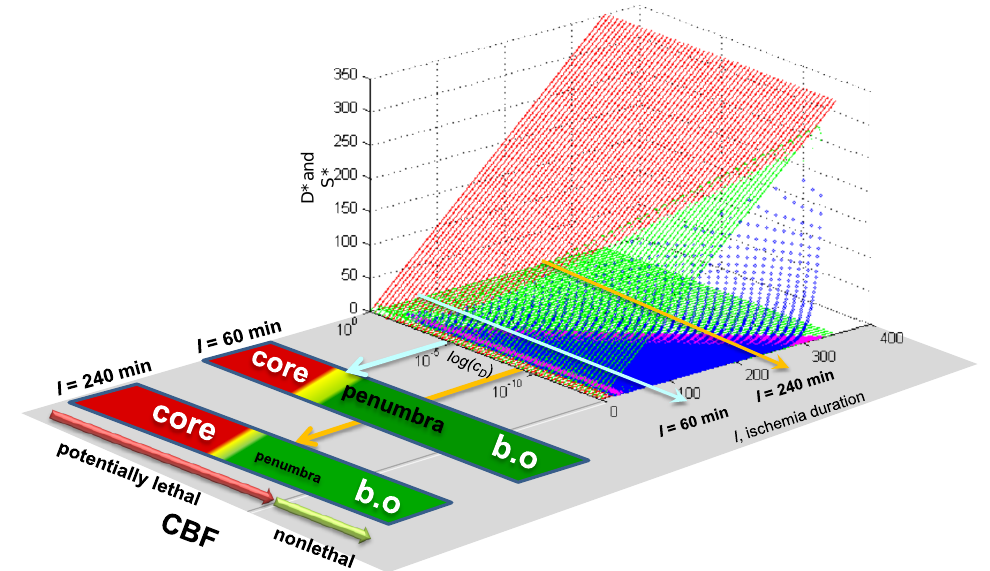
Figure 11. Outcome across the c /CBF continuum at two different values of I . Light blue D arrow on master bifurcation diagram indicates I = 60 min and corresponds to outcome plot labeled I = 60 min. Orange arrow on master bifurcation diagram indicates I = 240 min and corresponds to outcome plot labeled I = 240 min. Master bifurcation diagram applies only to the lethal CBF range of 0% ≤ CBF ≤ 40% as calculated by Equation (6). “Core”